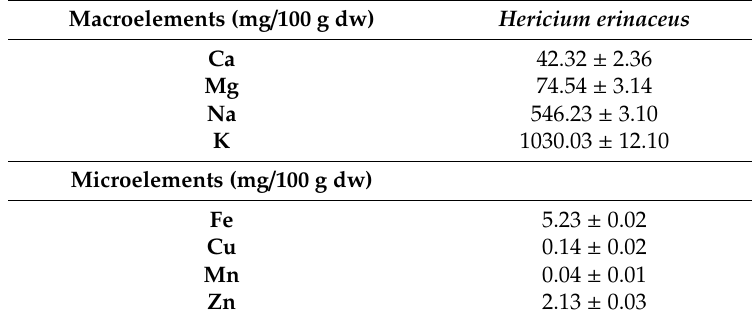
Table 4. Macro- and microelements in the Hericium erinaceus biomass developed in the